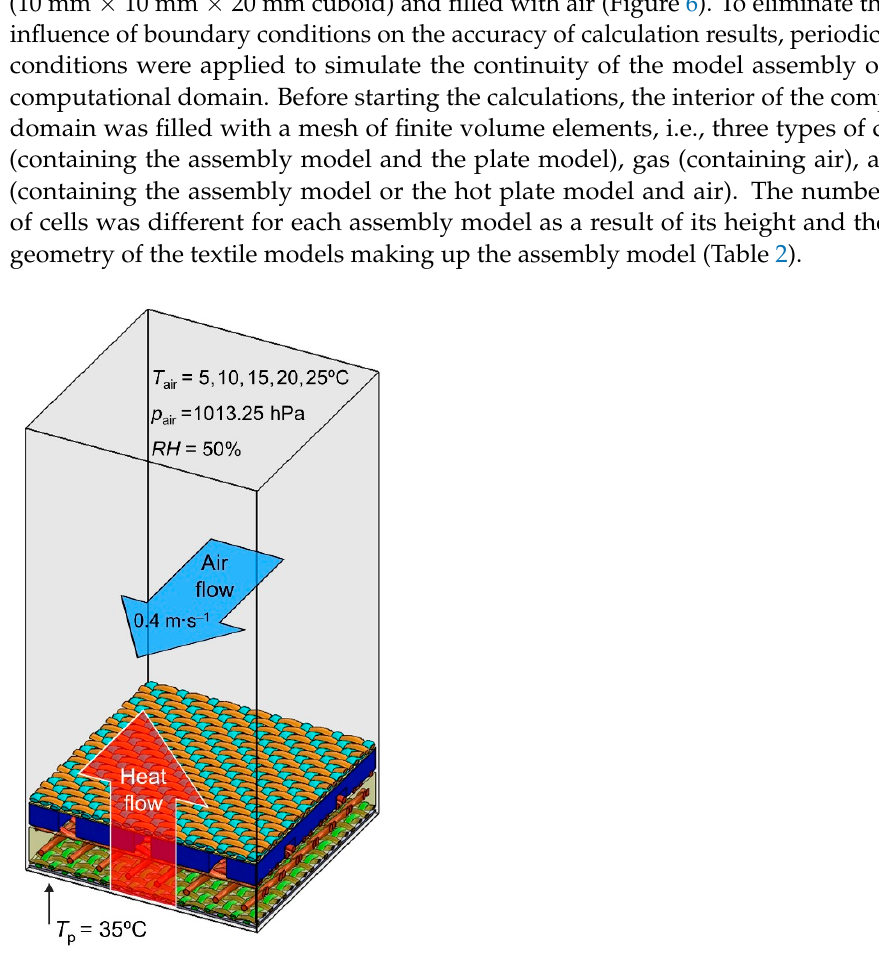
Figure 6. Initial conditions of simulations of heat transfer through assembly model. Table 2. Number of cells in tested assembly models.